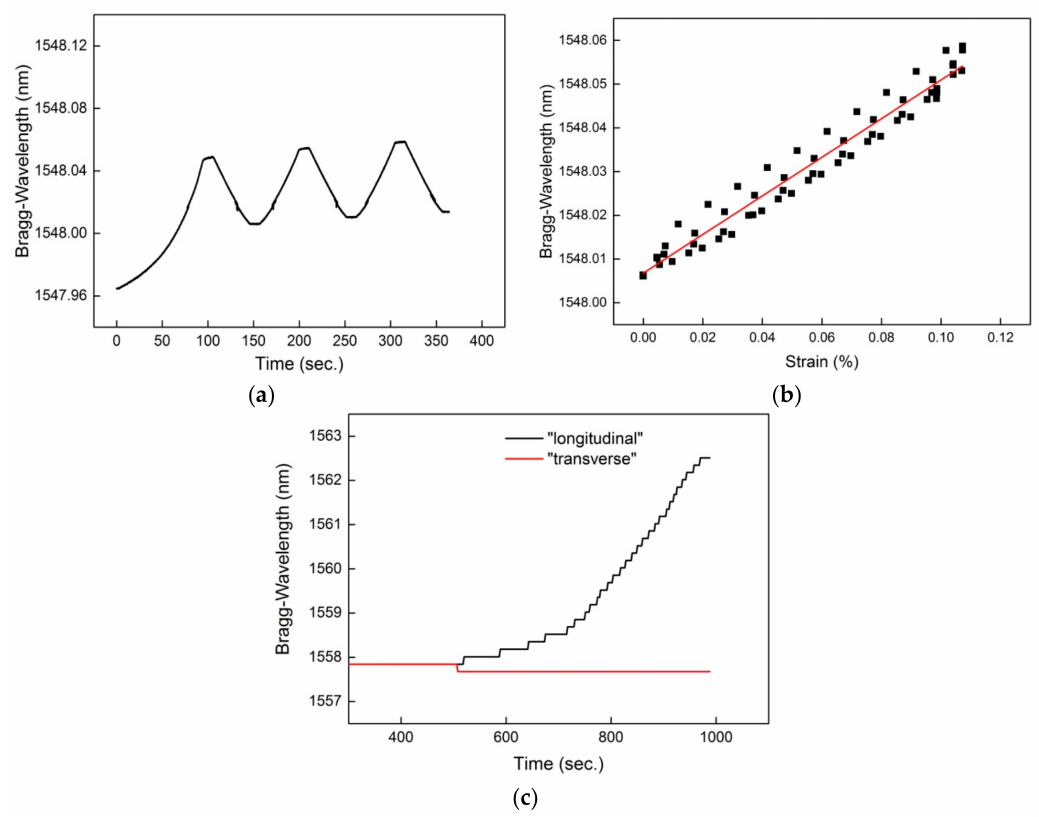
Figure 5. Readings of the FBG sensor of the FCS; ( a ) Sensor response by the FBG that is positioned longitudinal to the load; ( b ) FBG sensor indicates a linear response to applied load; ( c ) Minimal or no sensitivity of the FBG sensors to lateral